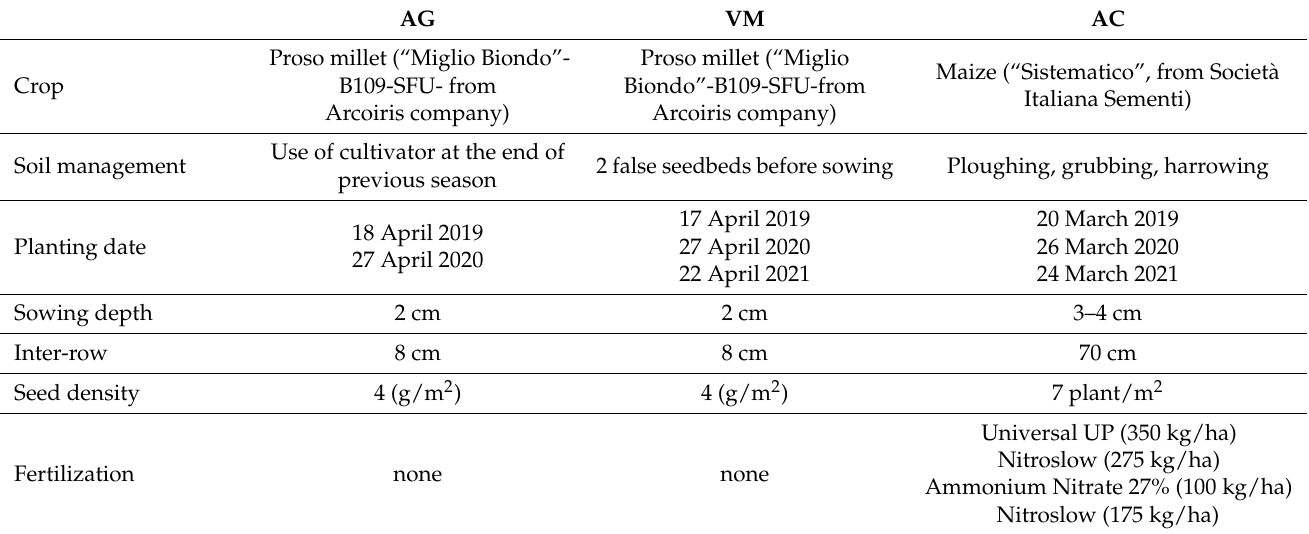
Table 1. Agronomic management for the three experimental